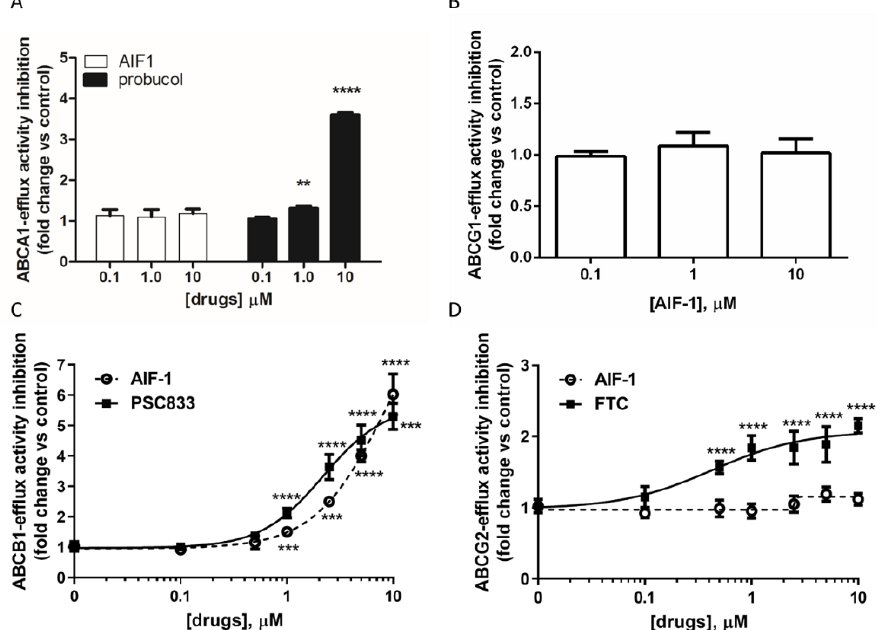
Figure 1. Characterization of AIF-1’s effects on different ATP-binding cassette transporters. ( A ) Effect on ABCA1 activity. Cholesterol efflux was evaluated in murine peritoneal macrophages (MPM), as described in Section 4. Relative ABCA1 activity was defined as the ratio of the percent of cholesterol efflux to apoA-I in untreated cells, and the percent obtained in cells treated with AIF-1 or probucol and is expressed as fold inhibition of activity compared to control. ( B ) Effect on ABCG1 activity. Cholesterol efflux was evaluated in Chinese hamster ovary cells, as described in Section 4. Relative ABCG1 activity was defined the ratio of percent of cholesterol efflux to HDL in untreated cells and the percent obtained in cells treated with AIF-1 and is expressed as fold inhibition of activity compared to control. ( C ) Effect on ABCB1 activity. Calcein AM fluorescence was determined in A549 cells as described in Section 4. Relative ABCB1 activity was defined as the ratio of calcein accumulation per microgram of protein between AIF-1 or PSC833-treated cells and untreated cells and is expressed as fold inhibition of activity compared to control. ( D ) Effect on ABCG2 activity. Hoechst 33342 fluorescence was determined in H460 cells by luminometer as described in Section 4. Relative ABCG2 activity was defined as the ratio of Hoechst 33342 accumulation per microgram of protein between AIF-1 or fumetrimorgin C-treated cells and untreated cells and is expressed as fold inhibition of activity compared to control. Statistical significance was calculated by ANOVA with Bonferroni’s post hoc analysis. Data are representative of at least three independent experiments with triplicate wells (n = 3). Values are expressed as mean ± SD. (** p < 0.01; *** p < 0.001; **** p < 0.0001 vs. control).